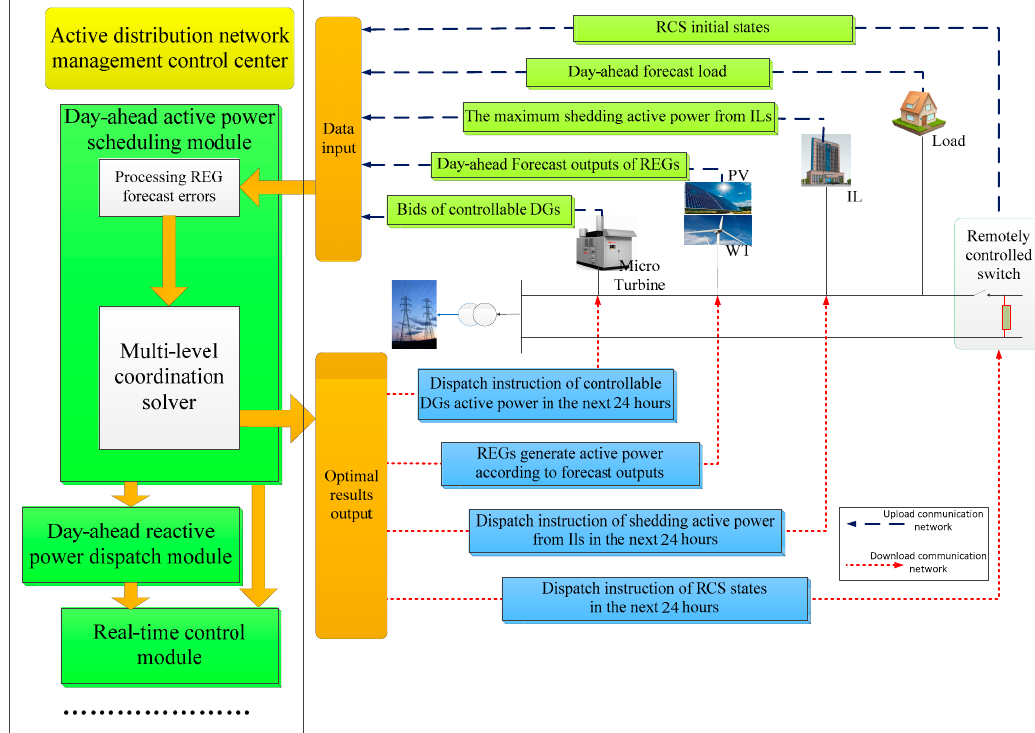
Figure 2. The practical implementation of day-ahead active power scheduling. DG: distributed generation; REG: renewable energy